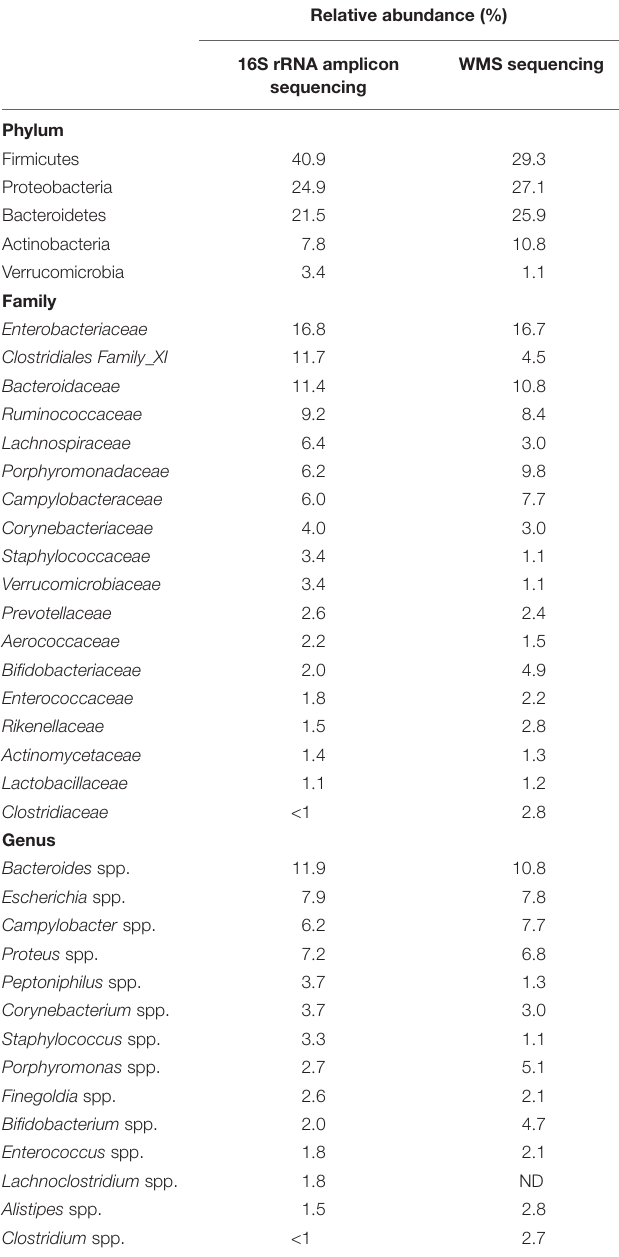
TABLE 2 | Comparison of relative abundances of the most abundant ( > 1%) taxa at the Phylum and family level and most represented taxa at the Genus level